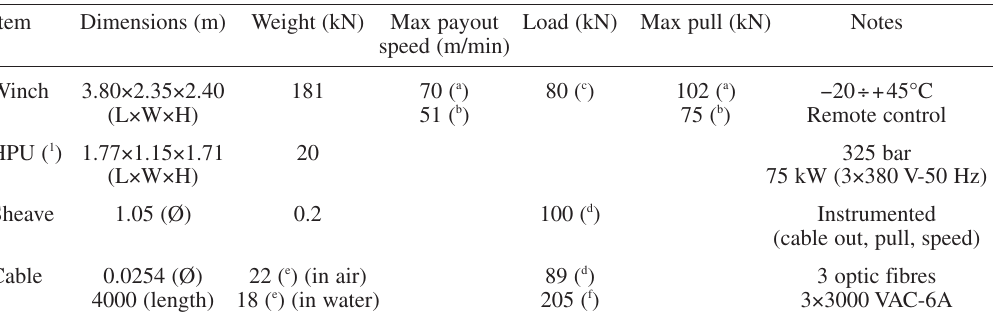
Table IV. Main characteristics of the winch (MacArtney) and cable